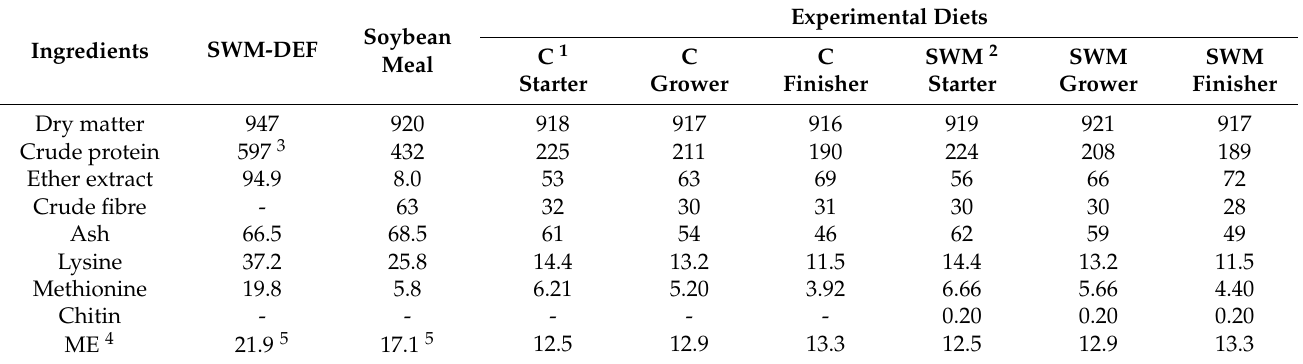
Table 2. Chemical composition of the experimental diets (g/kg, as feed basis) and metabolizable energy content (MJ/kg